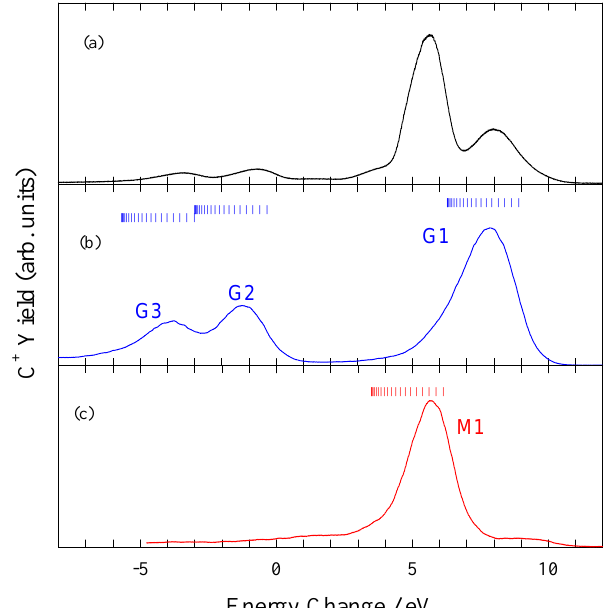
Figure 5: Energy change spectra for electron capture by (a) a mixed beam of ground state and me- tastable C 2+ ions, (b) a pure ground state beam of C 2+ ions, and (c) a pure metastable C 2+ beam [22].